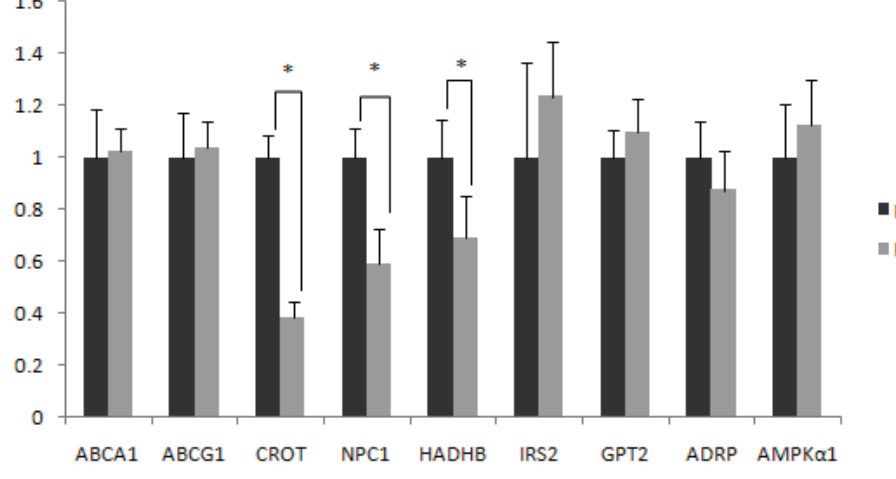
Figure 5. Detection of luciferase activity. * represents p < 0.05.